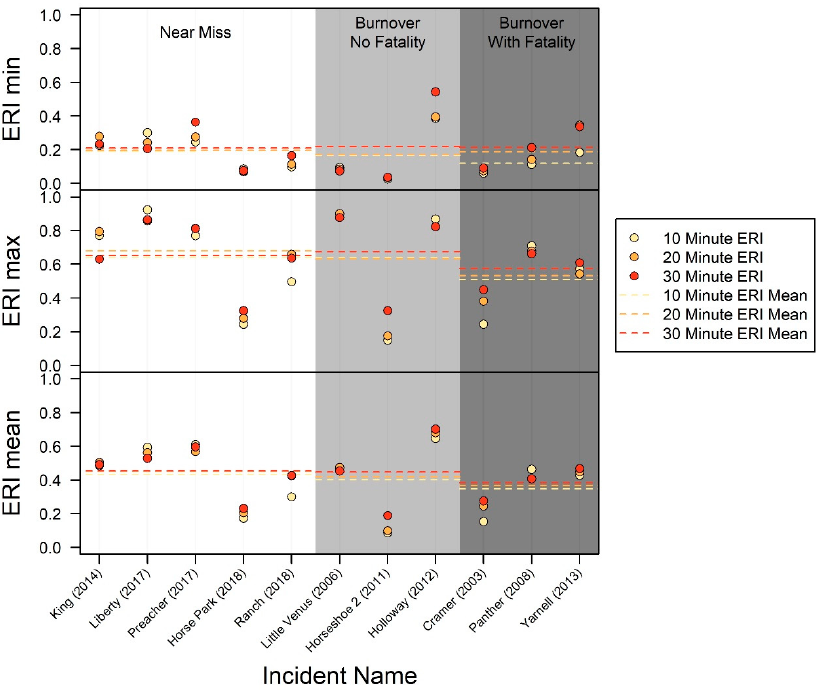
Figure 12. ERI min , ERI max , and ERI mean values modeled from the evacuation starting locations for several recent wildland firefighter entrapment incidents.